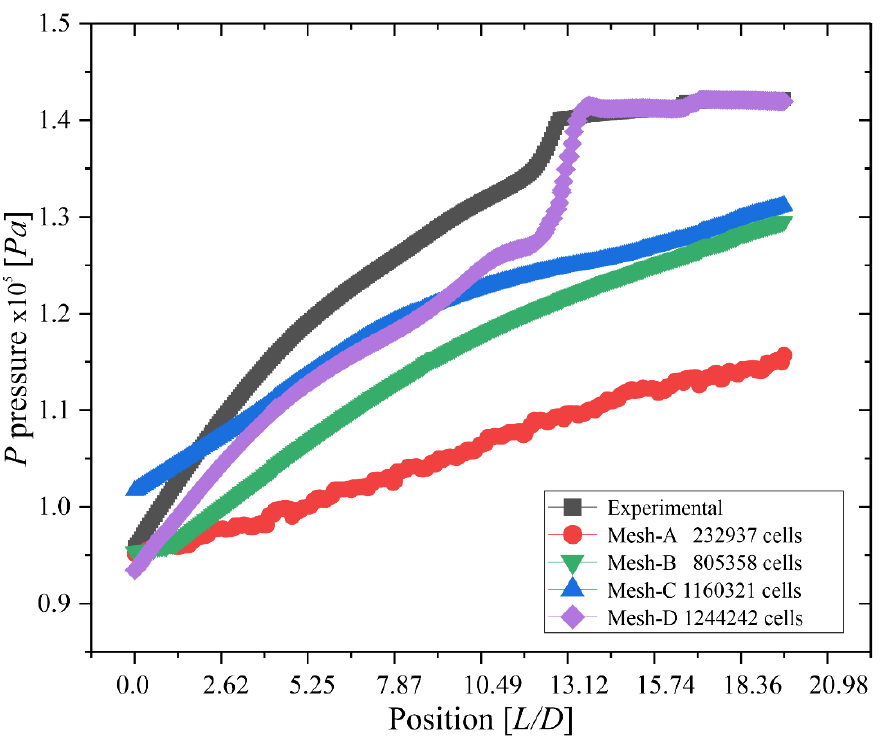
Figure 3. Pressure plot, values along the central marker. Experimental data obtained from [17].